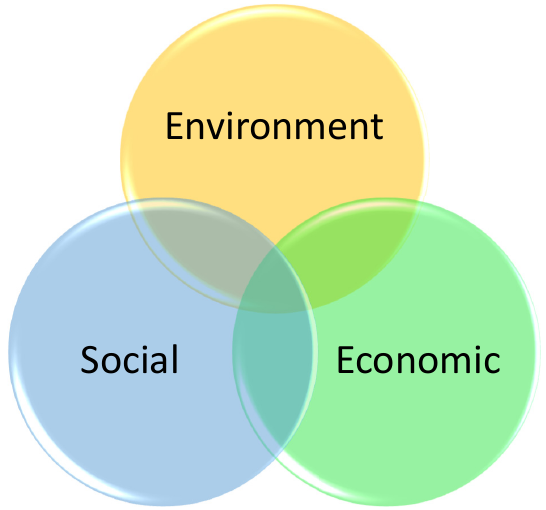
Figure 7. Sustainability triple bottom ‐ line framework.